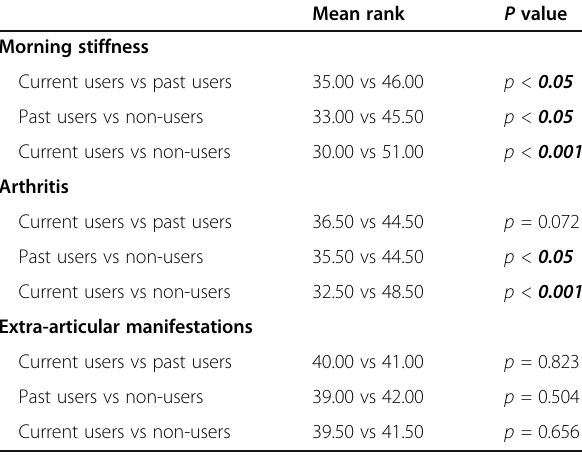
Table 3 Clinical manifestations of lactating women using OCs, lactating not using OCs and